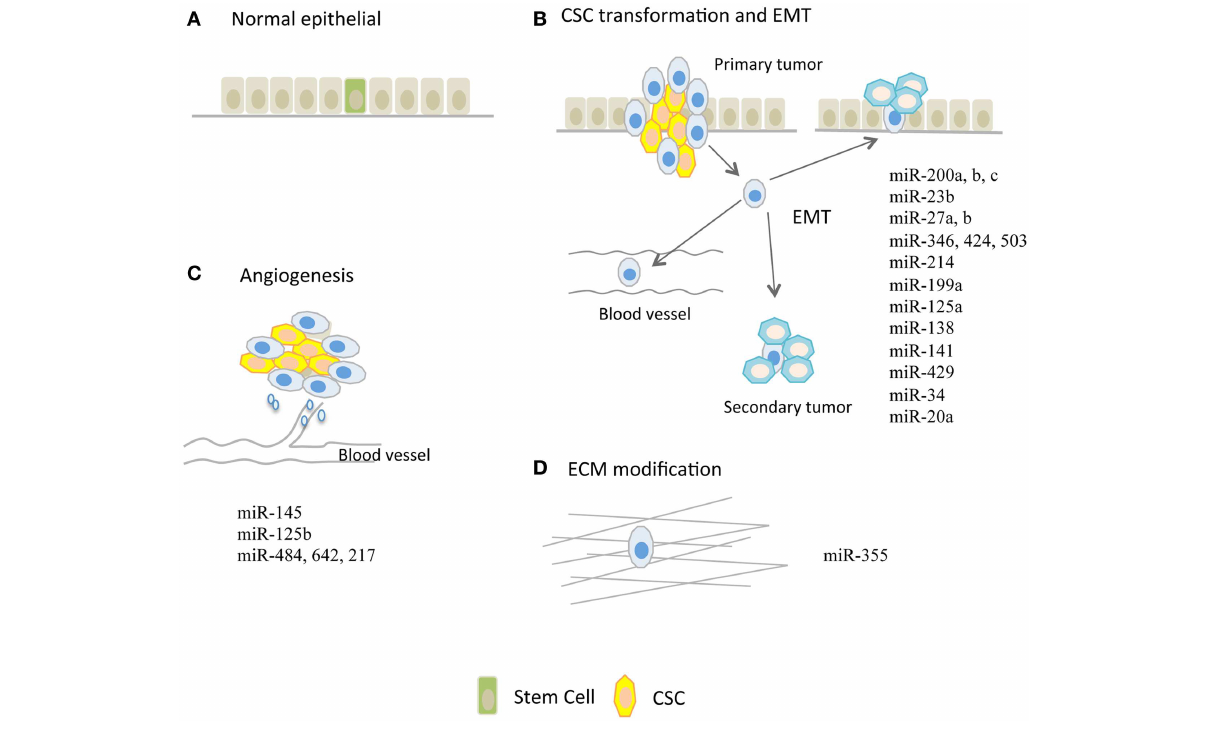
FIGURE 1 | microRNAs regulating tumor metastasis in ovarian cancer . (A) Normal epithelium and potentially harbored stem cells. (B) miRs that are implicated in modulation of cancer stem cell (CSC) transformation and epithelial–mesenchymal transition (EMT) process. (C) miRs that are involved